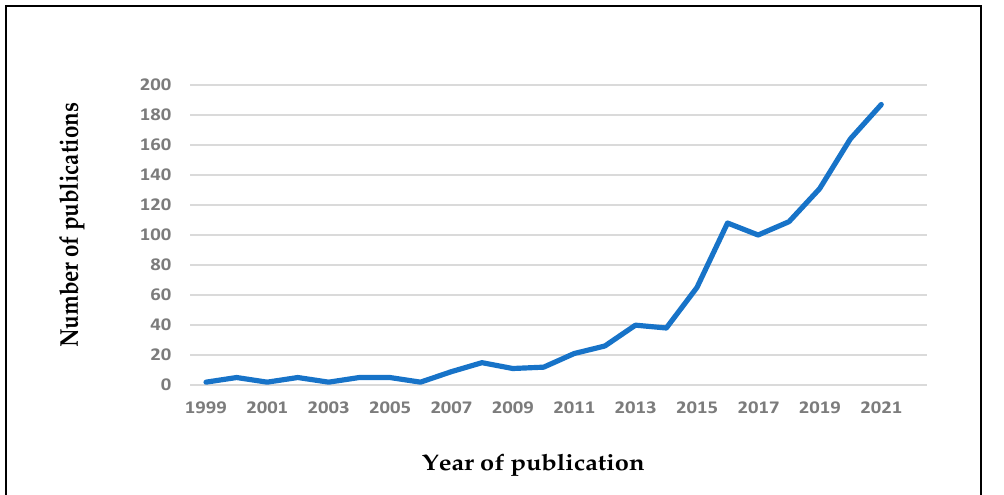
Figure 1. Trend of publications in English related to nutrition and autism spectrum disorders (ASD), from 1999 to 2021. Data from Pubmed, with the following keywords: nutrition, autism spectrum disorder; date of search 5 April 2022.